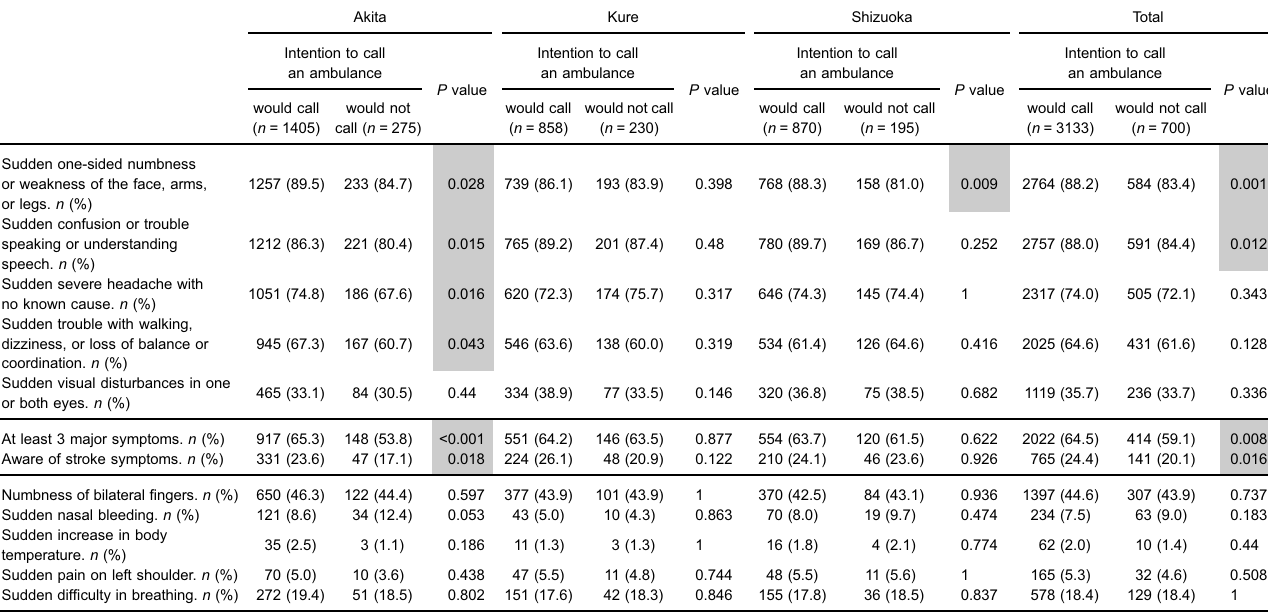
“ At least three major symptoms ” ; those who selected at least three symptoms including “ Sudden one-sided numbness or weakness of the face, arms, or legs ” , “ Sudden confusion or trouble speaking or understanding speech ” and “ Sudden severe headache with no known cause ” . “ Aware of stroke symptoms ” ; those who selected fi ve correct symptoms. The data were analyzed using Fisher ’ s exact test with 2 tails, and are shown as numbers (%). Shaded columns show signi fi cant P value